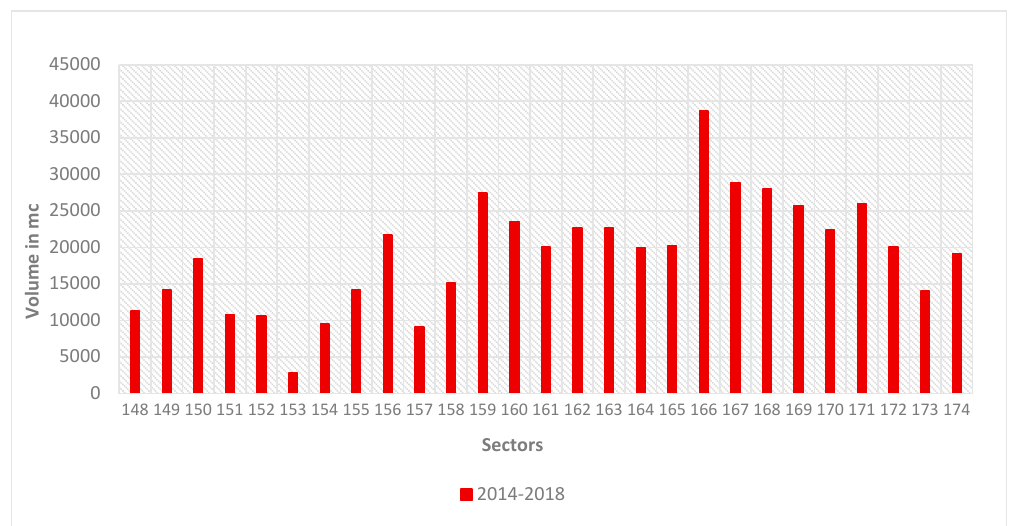
Figure 12 . Volumetric variations between “ − 1m” and “ − 7m” depth at North and South Harbor subunits (the time frame 2006–2018 represents the total volumetric variations calculated).